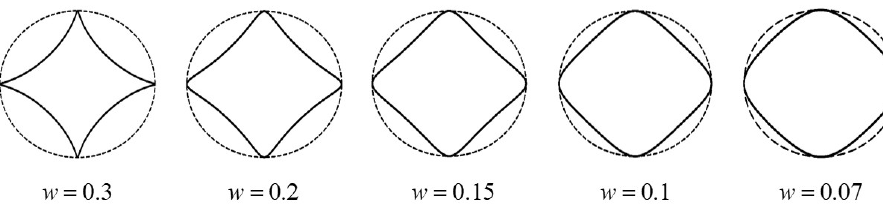
Figure 5. Configuration of approximately square holes with different shape factors.